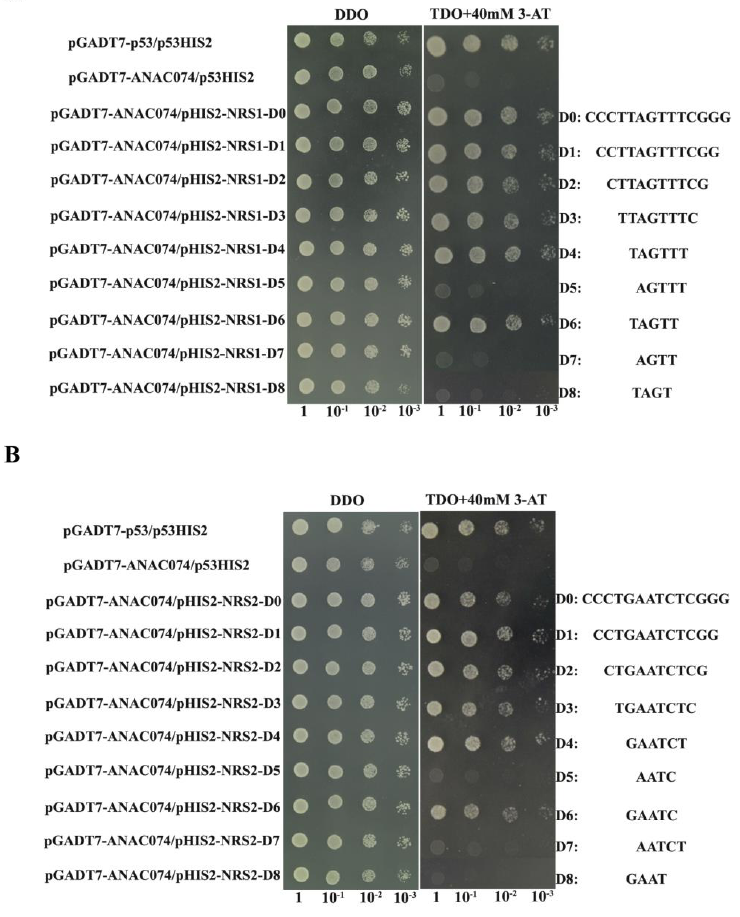
Figure 1. Serial deletion of the inserted sequence to determine the motif recognized by ANAC074. ( A ) Serial deletion of the inserted sequence to determine the exact sequence of NRS1 recognized